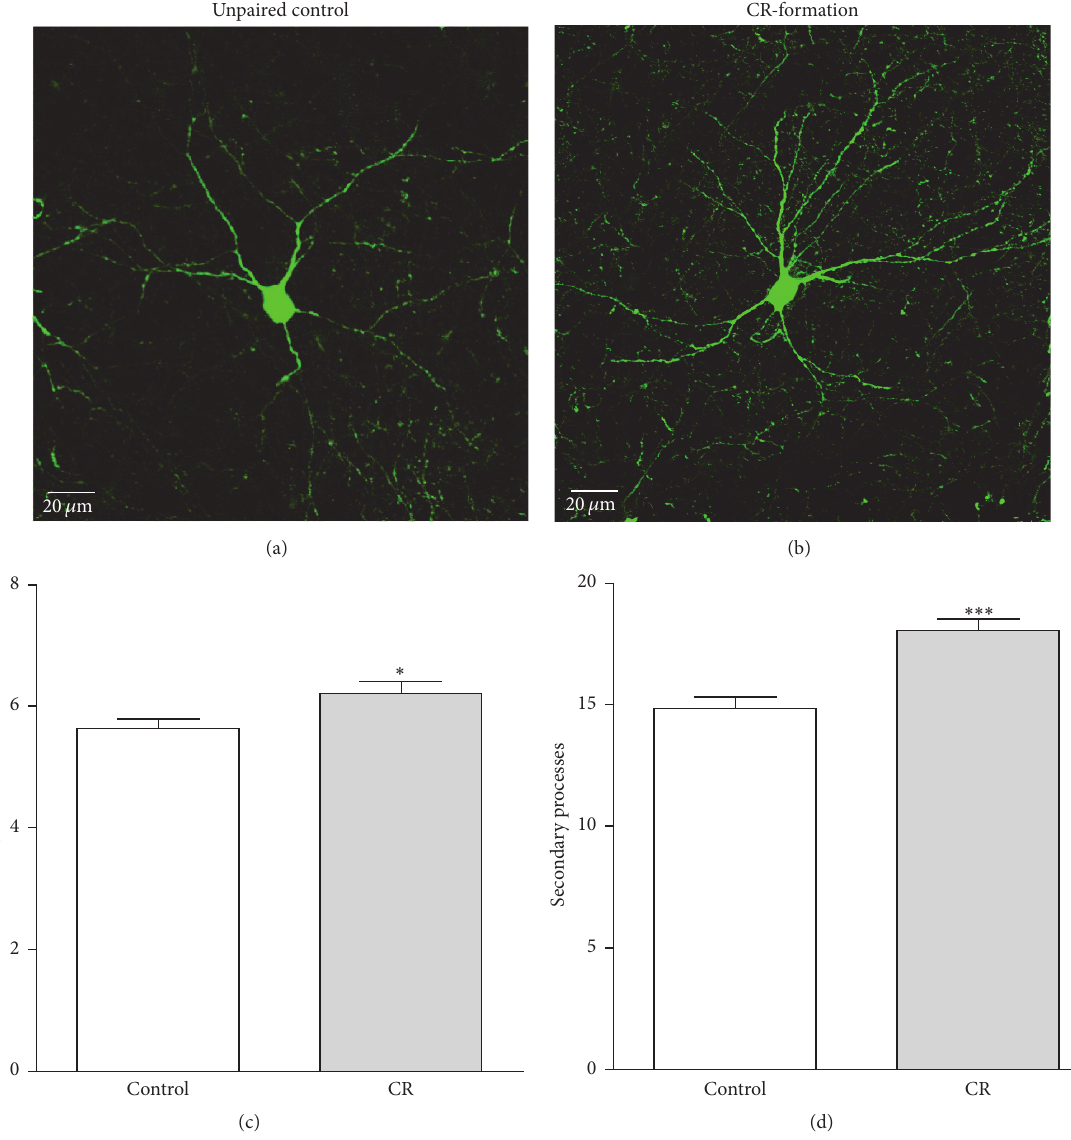
Figure 6: The processes of GABAergic neurons in the barrel cortices increase after pairing WS and OS. (a) ∼ (b) illustrate that process branches appear denser in CR-formations (a) than controls (b). (c) Primary processes per GABAergic neuron are higher in CR-formation mice (gray bar, 𝑛 = 43 ) than controls (white, 𝑛 = 40 ; asterisk, 𝑝 < 0.05 ). (d) The secondary process branches per neuron are higher in CR-formation (gray bar) than control mice (white bar, three asterisks, 𝑝 < 0.001